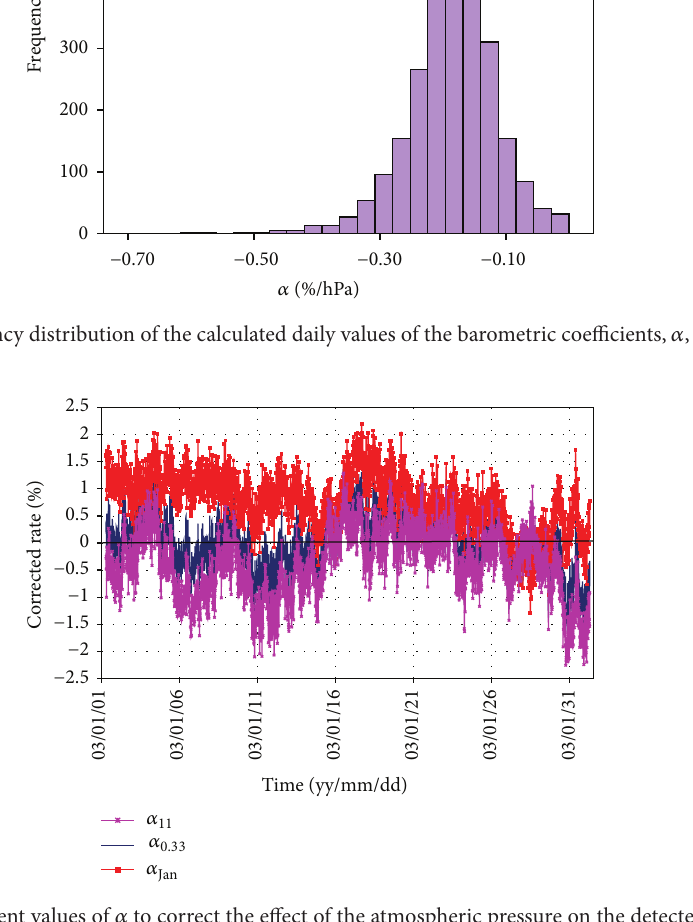
Figure 3: The effect of using different values of 𝛼 to correct the effect of the atmospheric pressure on the detected cosmic ray muon for the whole month of January 2003. The 𝛼 values used were 𝛼 11 (eleven years average value), 𝛼 Jan (obtained for this specific month), and 𝛼 0 . 33